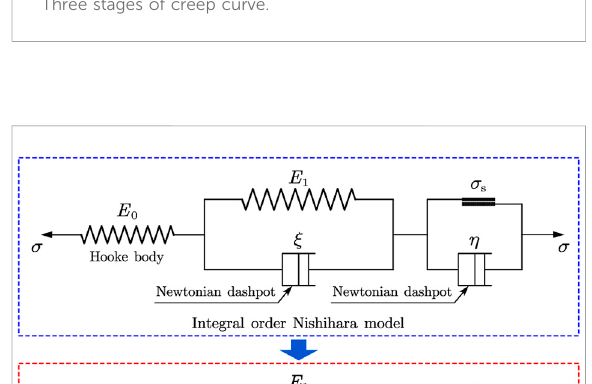
FIGURE 9 Three stages of creep curve.